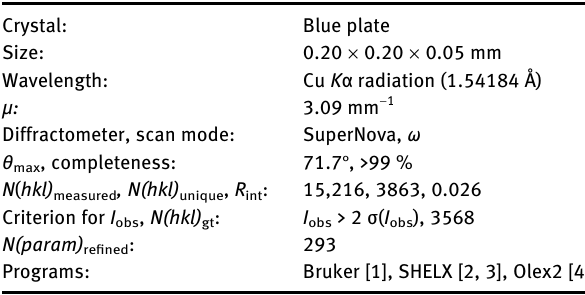
Table  : Data collection and